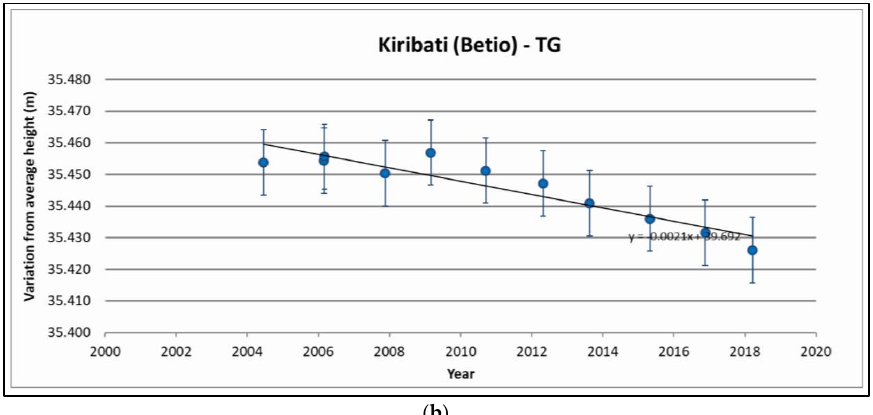
Figure 4. ( a ) The height changes of the GNSS site from the Betio tide gauge. The dots show the GNSS site heights recorded on a weekly basis. The error bars are shown with the light blue line given at a 95% confidence interval. ( b ) The absolute height changes of the tide gauge with the error bars at a 95% confidence interval. Source: Pacific Sea Level Monitoring Project (bom.gov.au accessed on 10 February 2022).